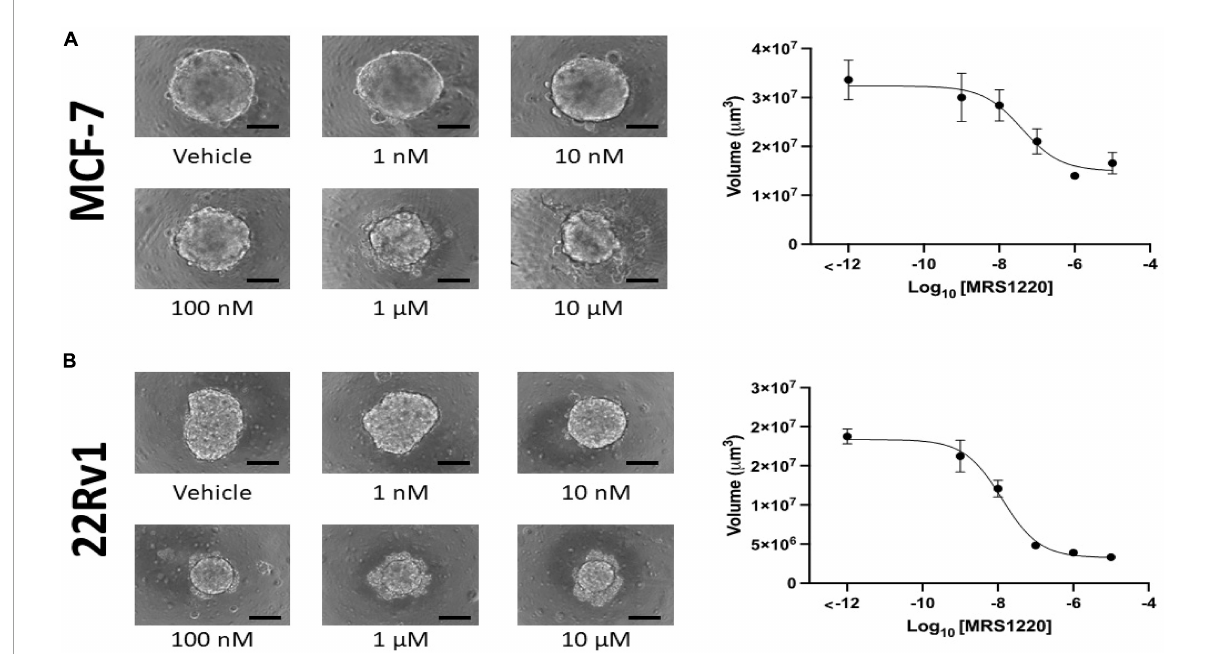
FIGURE6 Adenosine A3 receptor antagonist MRS-1220 inhibits MCF-7 and 22Rv1 cells in a dose-dependent manner. We incubated 2000 MCF-7 (A) and 22Rv1 (B) cells in 3D culture conditions for 1 week before determining sphere volume. A dose-dependent inhibition was observed in both cell lines, with EC50 values of 39 nM (95% CI 11.27–110 nM) in MCF-7 cells and 13 nM (95% CI = 8.629–18.39 nM) in 22Rv1 cells. Scale bar = 200 µ